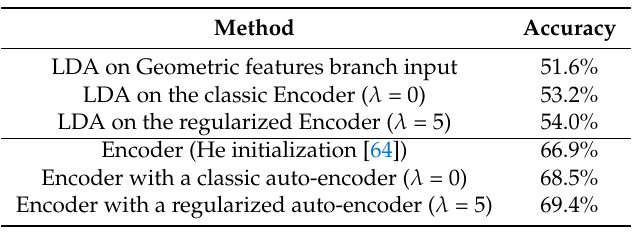
Table 1. Intention prediction accuracies of the Geometric branch alone, for different encodings of the sequences of inter-keypoints distances.